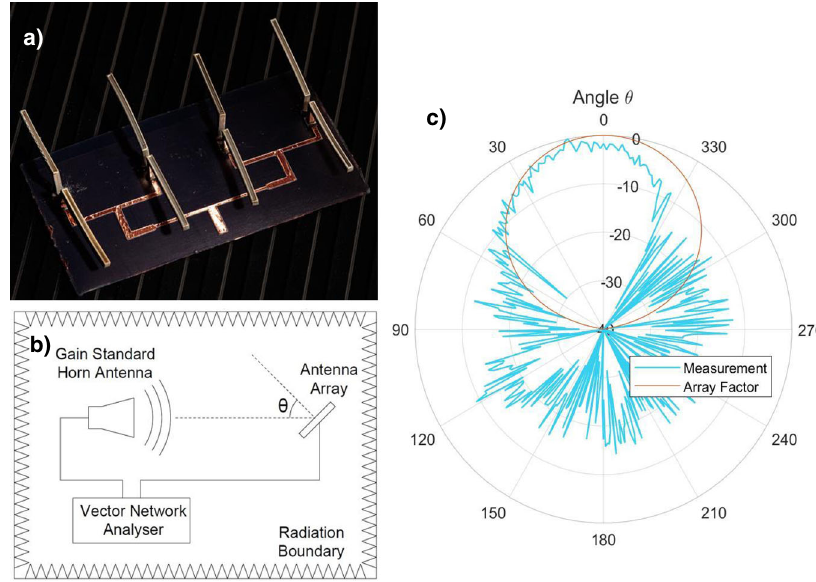
Fig. 6 3D printed dipole antenna array. a Photograph of antenna array (dimensions 10 cm by 10 cm). b Functional anechoic chamber layout showing transmission between a gain standard horn antenna and antenna array under test. c 3D printed dipole antenna array normalized radiation pattern at 2.4 GHz compared with ideal array